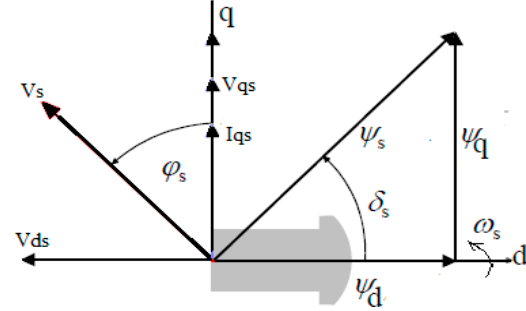
Figure 4. HEPMSM phasor diagram with zero direct-axis (ZDAC).